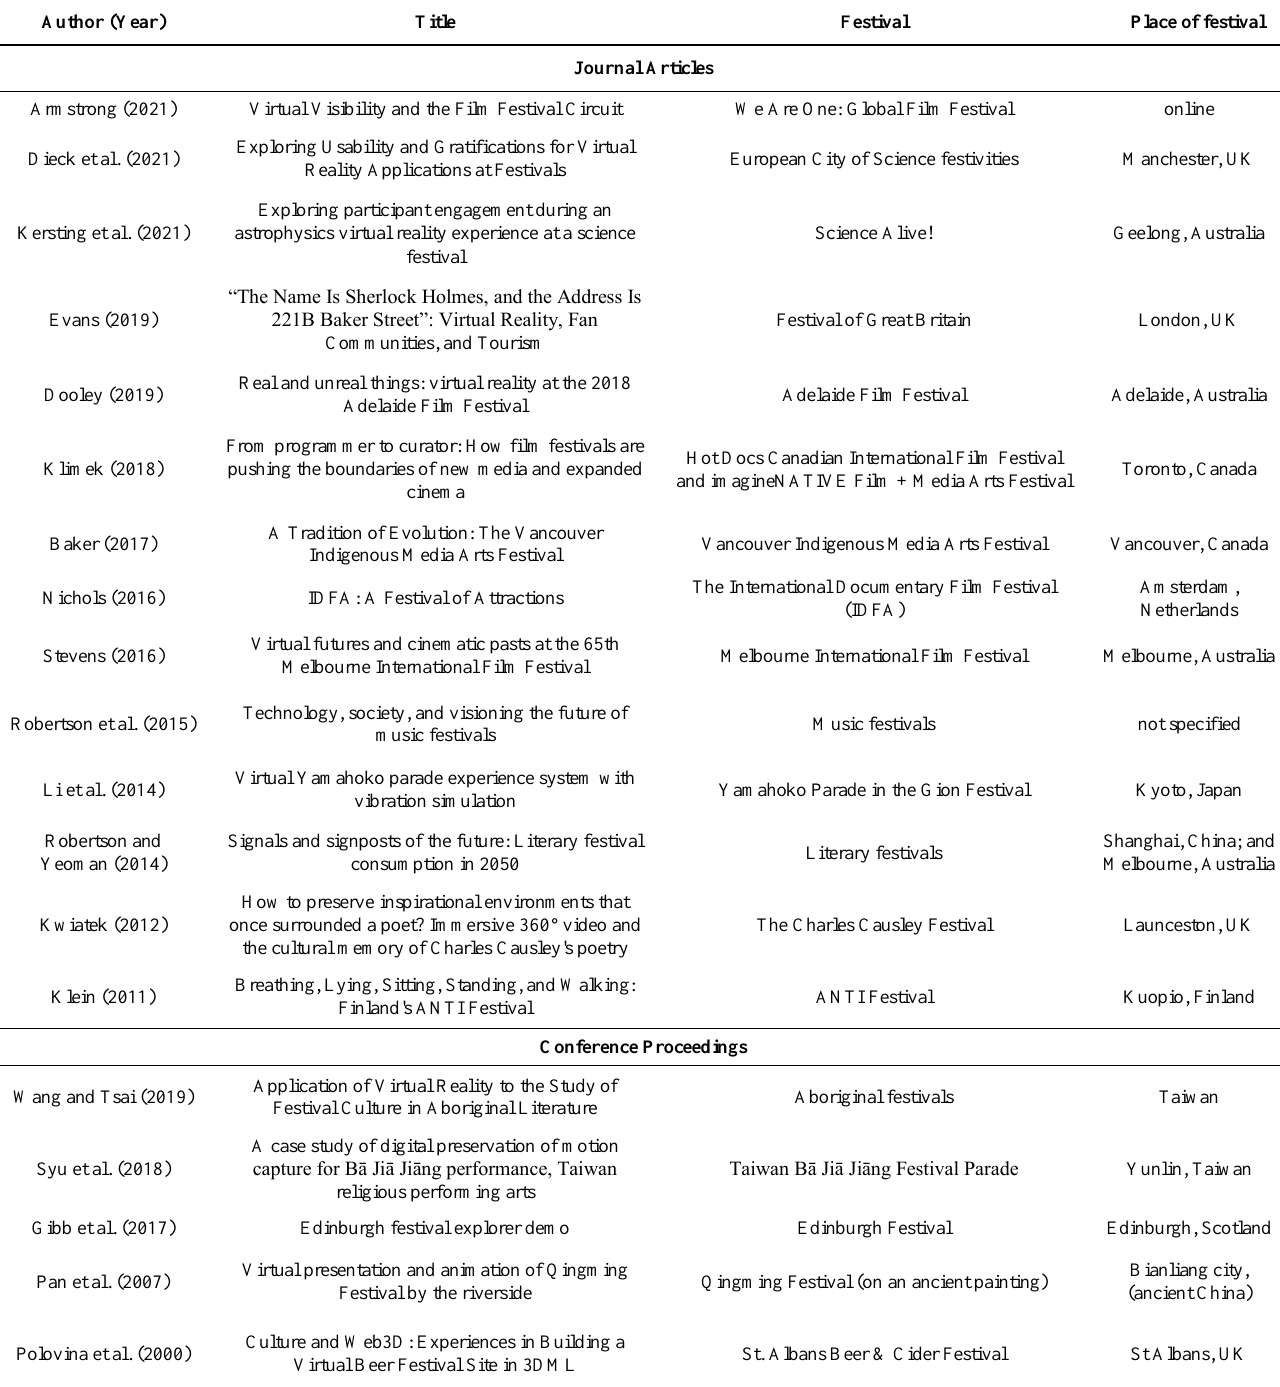
Table 1. Summary of articles used in the literature